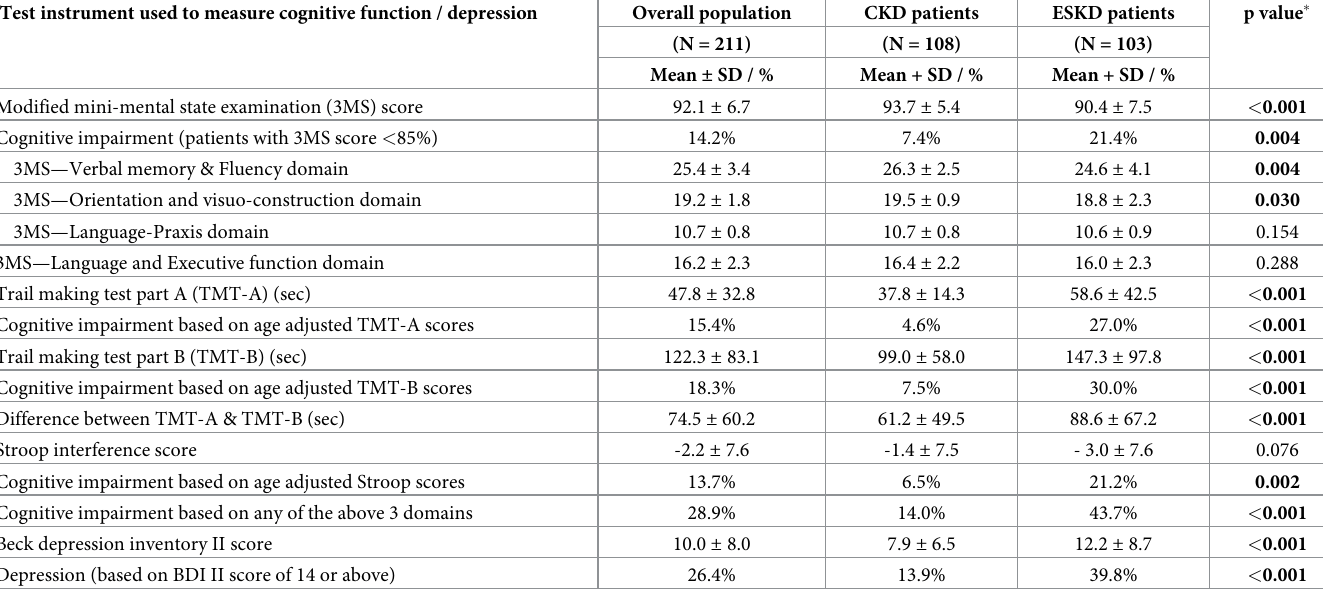
Table 2. Baseline markers of cognitive function and depression among the study participants comparing non-dialysis CKD and ESKD patients. Test instrument used to measure cognitive function / depression